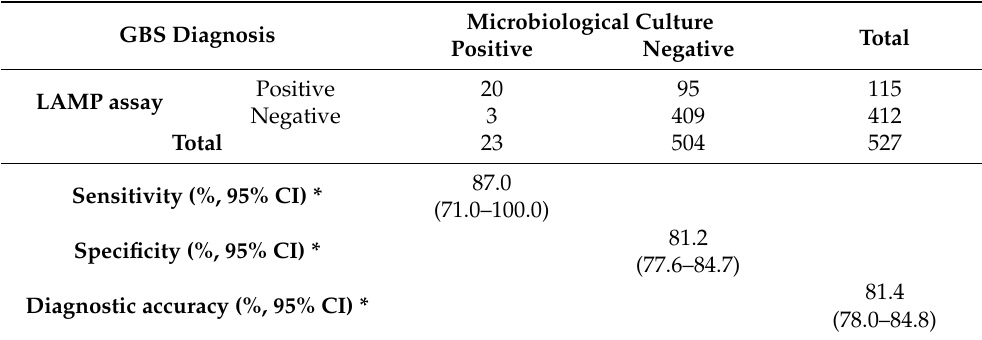
Table 2. Diagnostic performance of LAMP assay with reference to microbiological